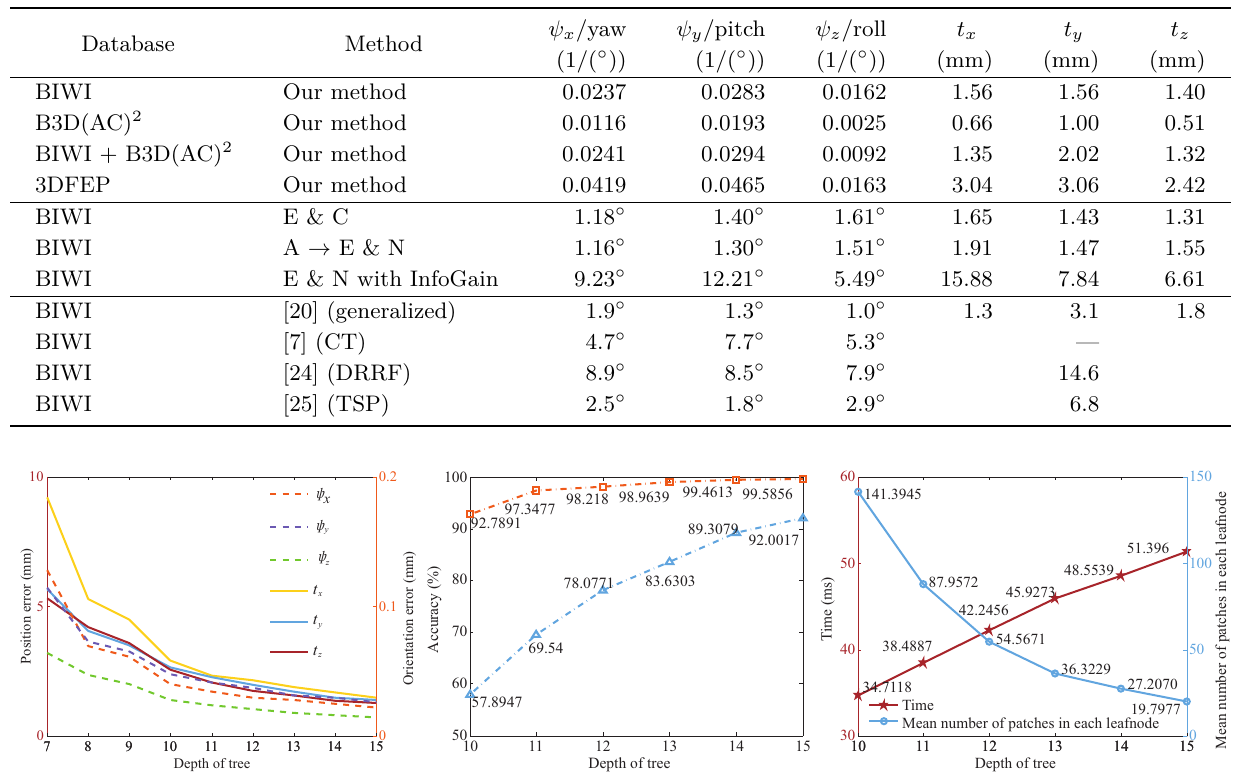
Table 2 Head pose estimation results. The first four rows give results using different databases and our method; the associated training parameters are given in Table 1. The next three rows show results for head pose by transforming the estimated pose from axis–angle representation to Euler angle form (A → E & N). We also compare results with different loss functions: entropy and information gain. The last four rows give head pose estimation results from other methods